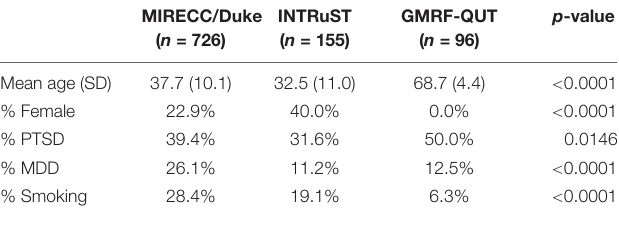
TABLE 1 | Sample characteristics by